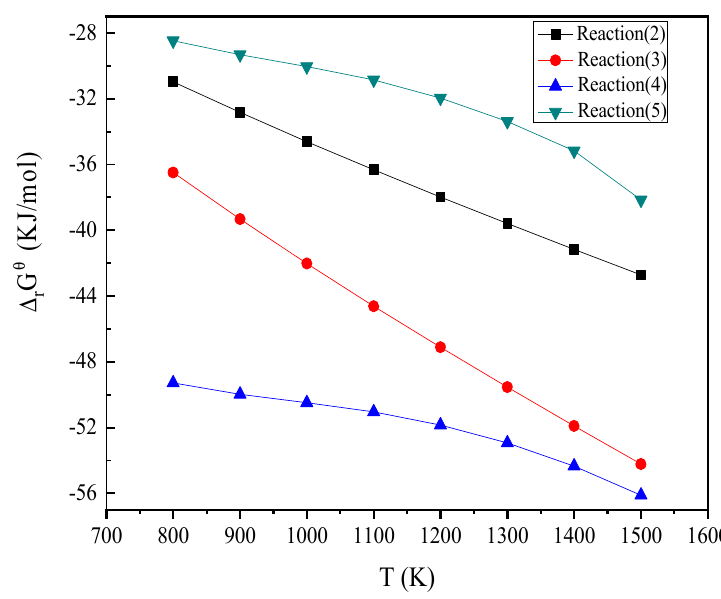
Figure 3. The Gibbs free energy and temperature variation curves of the reaction type (2) to reaction type (5) over the range 800 K to 1500 K (527 °C to 1227 °C).